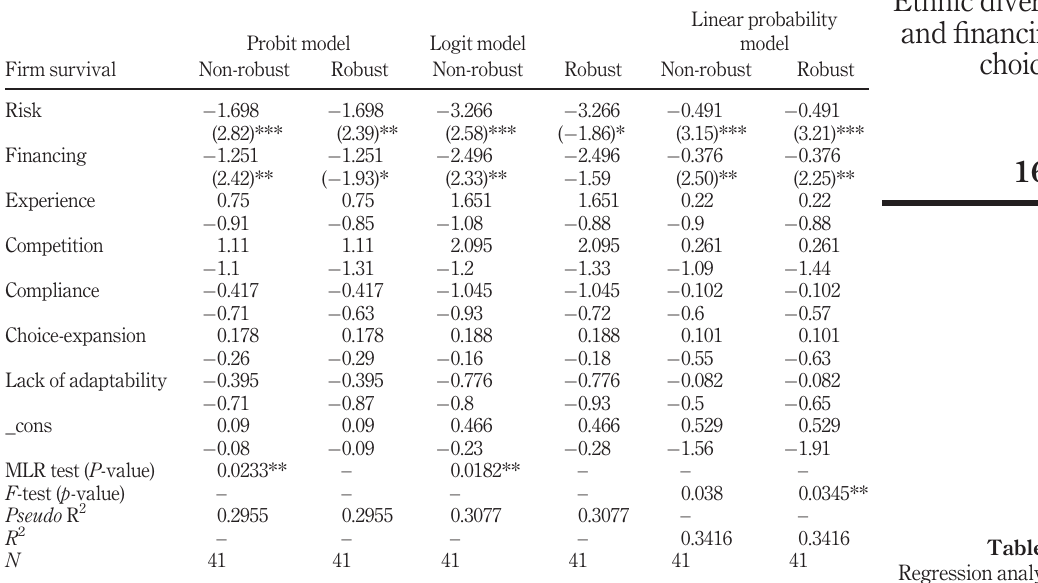
Table 6. Regression analysis